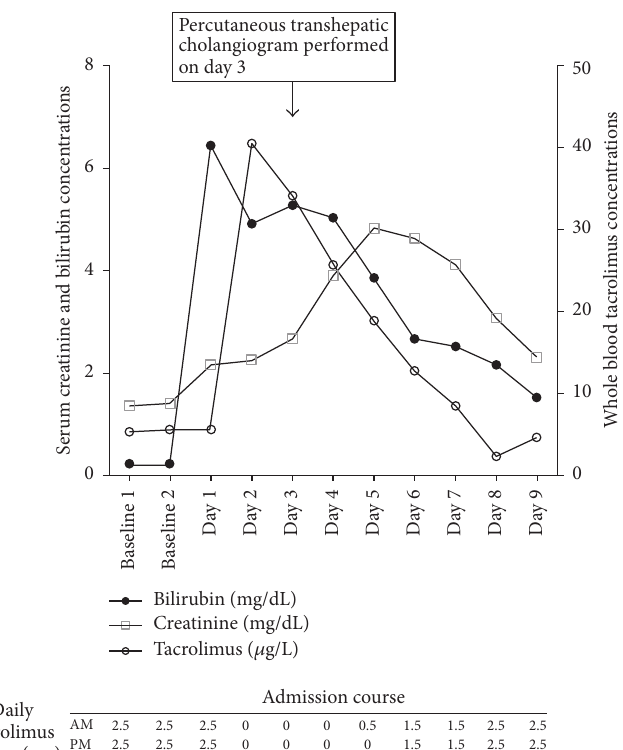
Figure 2: Serum bilirubin, creatinine, and tacrolimus concentrations and total daily tacrolimus dosage throughout patient